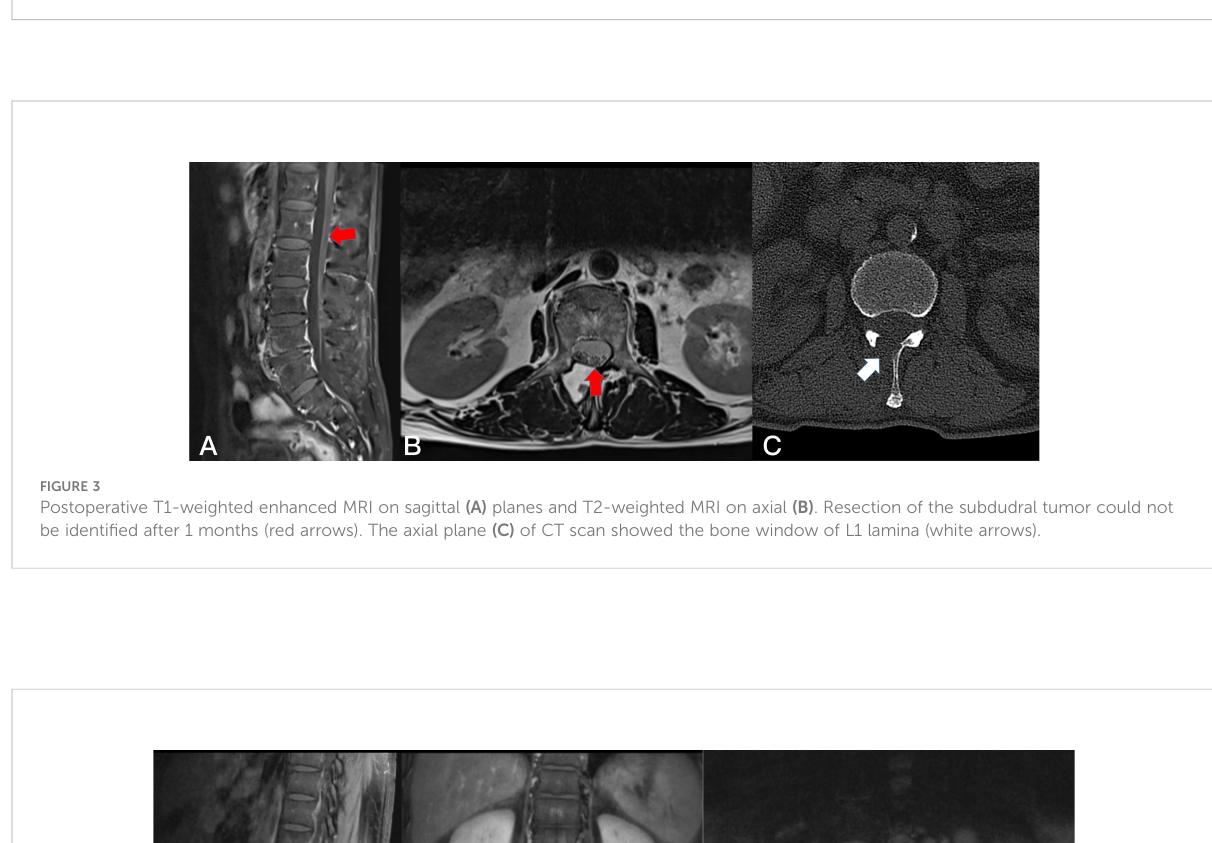
FIGURE 2 Preoperative T2-weighted MRI on sagittal (A) plane, T1-weighted enhanced sagittal (B) plane, and axial (C) planes, revealing a subdural tumor in the L1-2 segment (red